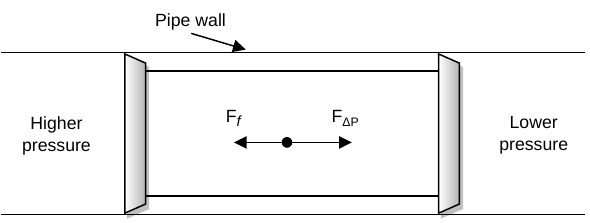
Figure 4. Forces involved in PIG